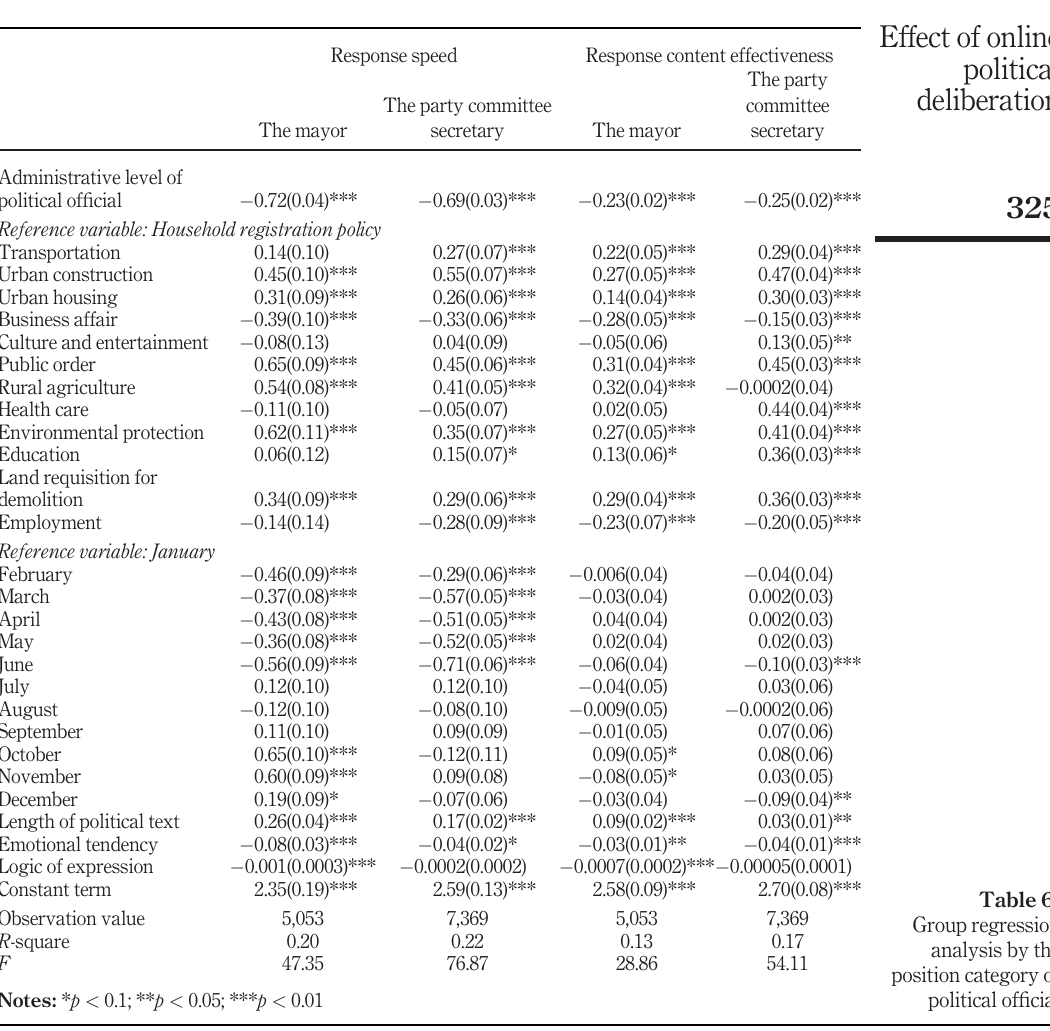
analysis by the position category of political of fi